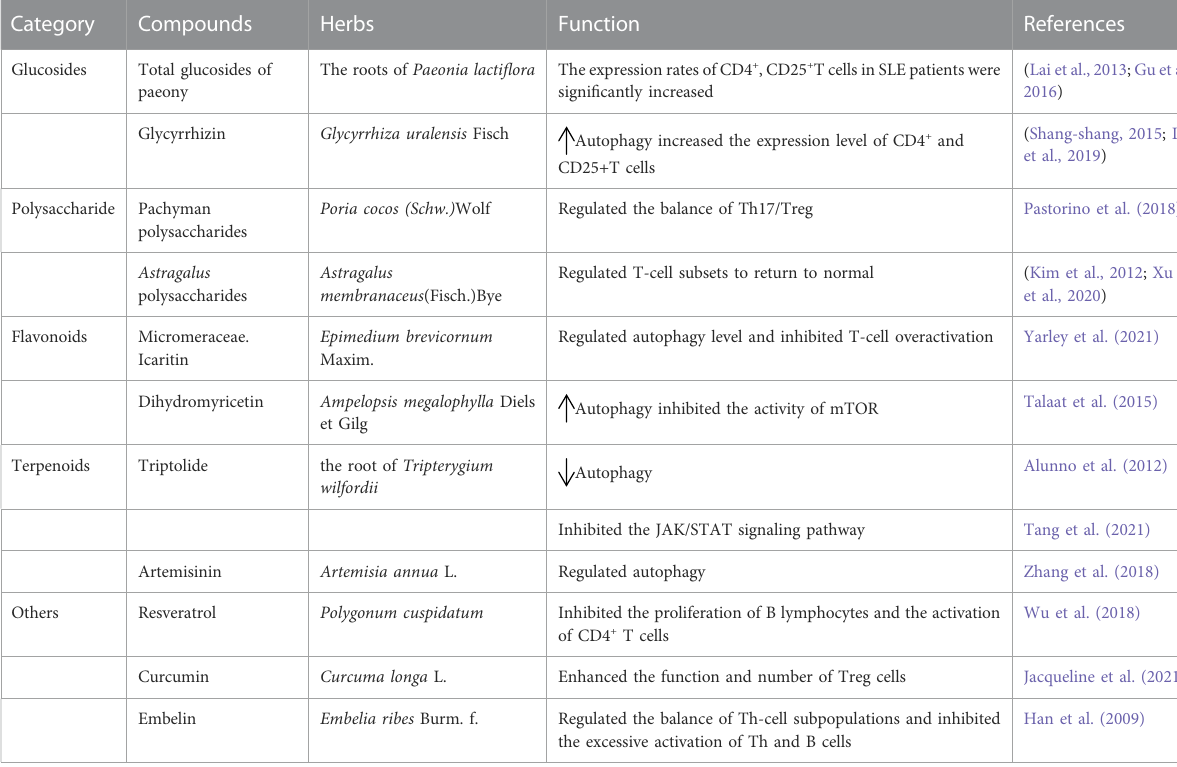
TABLE 1 Novel treatment strategies targeting SLE via